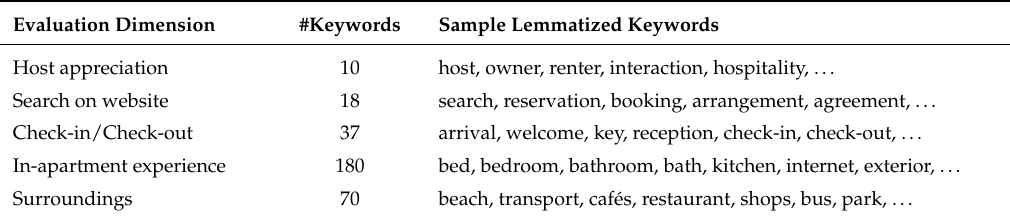
Figure 4. The upper portion of this figure shows the Service Journey Map related to the home booking experience. Each stage of the map is connected to the associated evaluation dimensions. Evaluation dimensions are colored as in the user interface of the Apartment Monitoring application. Table 2. Evaluation dimensions and sample lemmatized keywords for the thesauri of the home booking domain. Table A1 in the Appendix A shows the complete